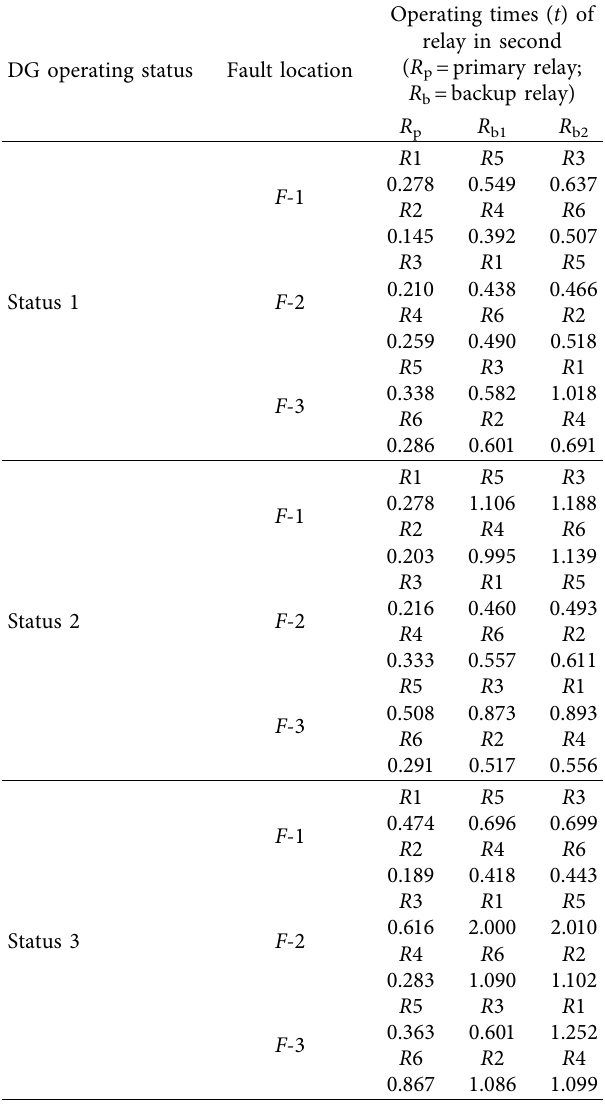
Table 6: DOCR settings for conventional protection scheme. Table 8: Directional primary and backup relay operating times for conventional scheme in islanded